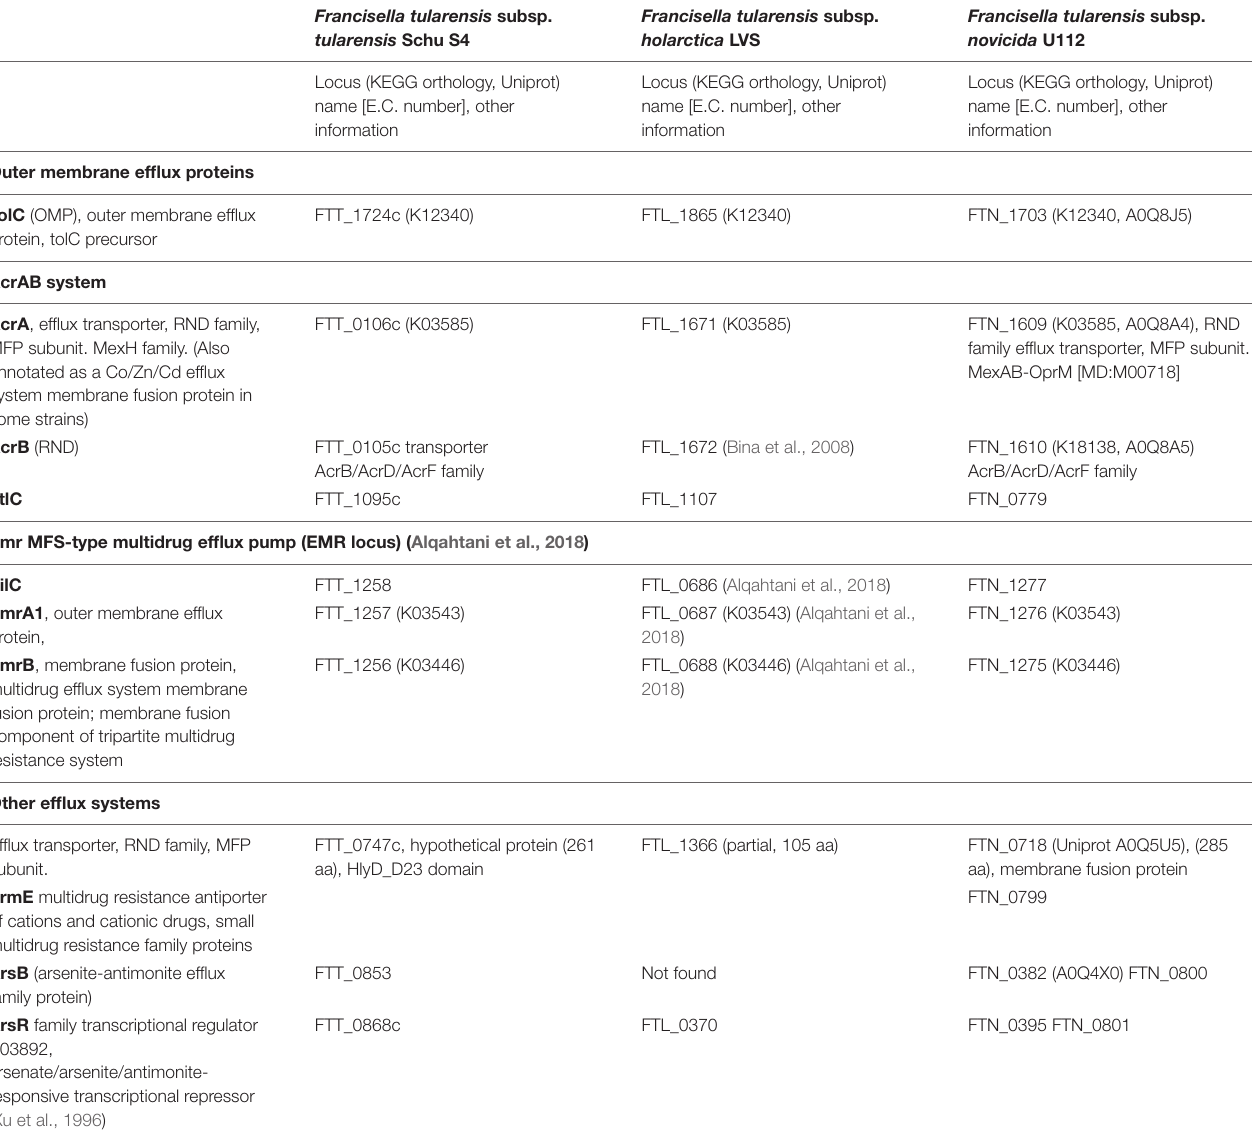
TABLE 4 | The annotated efflux pumps in Francisella species and